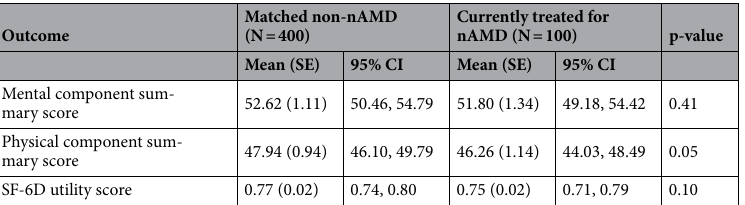
Table 4. Adjusted means with 95% CIs examining the effect of treated nAMD on health-related quality of life after controlling for demographics and health characteristics among currently treated nAMD patients and matched non-nAMD respondents. CI confidence interval, nAMD neovascular age-related macular degeneration, SE standard error.